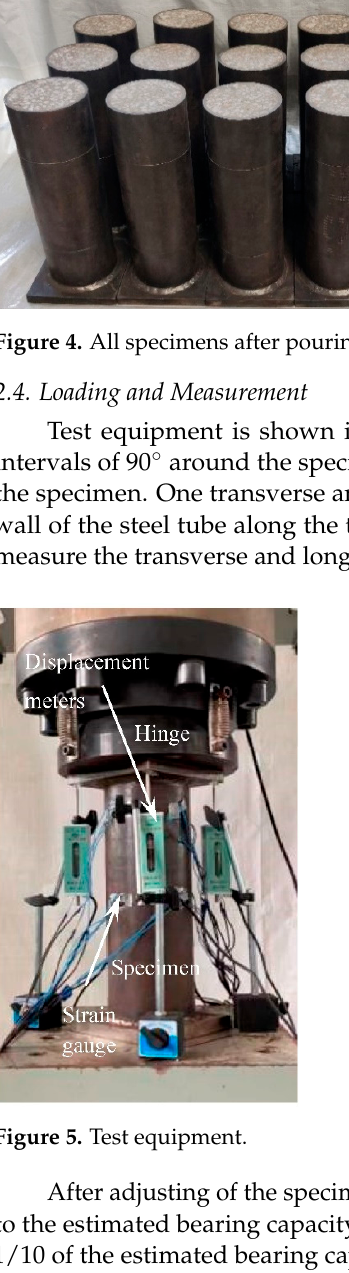
Figure 3. Schematic diagram of steel components of some specimens. All specimens after pouring concrete are shown in Figure 4.